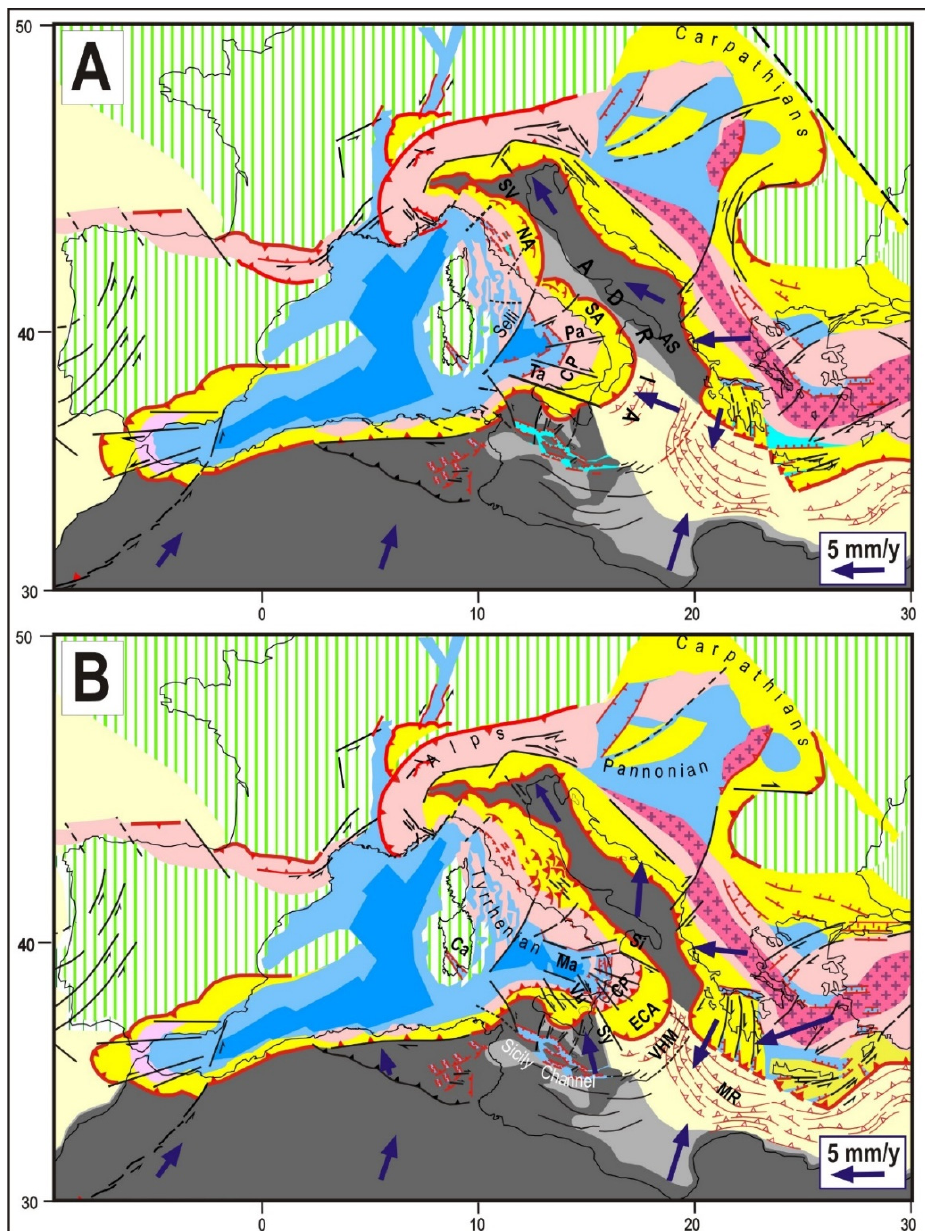
Figure 10. ( A ) Early Pleistocene tectonic setting. Since the suture of the Southern Apennine consuming boundary the lateral escape of the Alpine–Apennine material has only involved the Calabria-Peloritani (CP) wedge, which has extruded roughly southeastward at the expense of the Ionian oceanic domain. Stressed by E-W compression, the southern Adriatic platform has undergone upward flexure, accelerating the formation of the Apulian Swell (AS). Accretionary activity along the outer Calabrian front has formed the External Calabrian accretionary belt (ECA), whereas crustal extension has developed in the wake of the migrating Arc, forming the Marsili basin (Ma). In this strong compressional context, the CP wedge has undergone fast uplift, bowing and fragmentation. Pa = Palinuro fault, Ta = Taormina fault. ( B ) Late Pleistocene tectonic setting. The potential gravitational energy accumulated by the southern Adriatic in the previous phase has triggered the northward displacement of Adria. Since the collision of the extruding CP wedge with the Adriatic continental domain, the escape trend of such wedge changed by activating new lateral guides, the Sibari (Si) and Vulcano–Syracuse (Vu-Sy) faults. MR = Mediterranean ridge. Colours and symbols as in Figures 1 and 5.